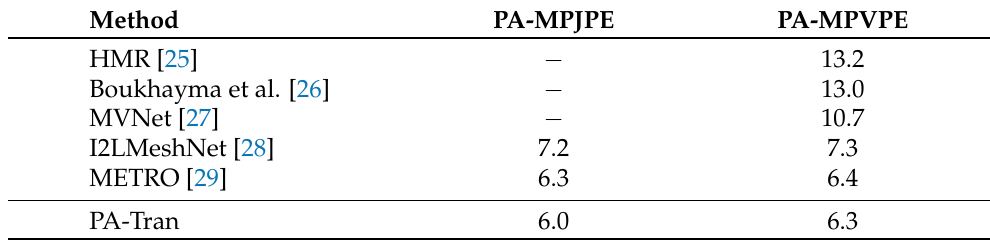
Table 3. Comparisons of the 3D HPE results with SOTA methods on FeriHAND dataset.